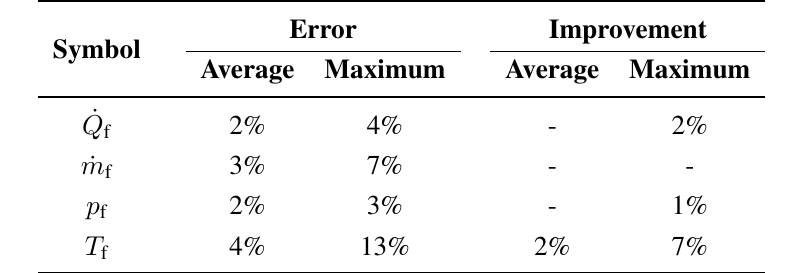
Table 1. Summary of the model prediction error and improvement compared with data from